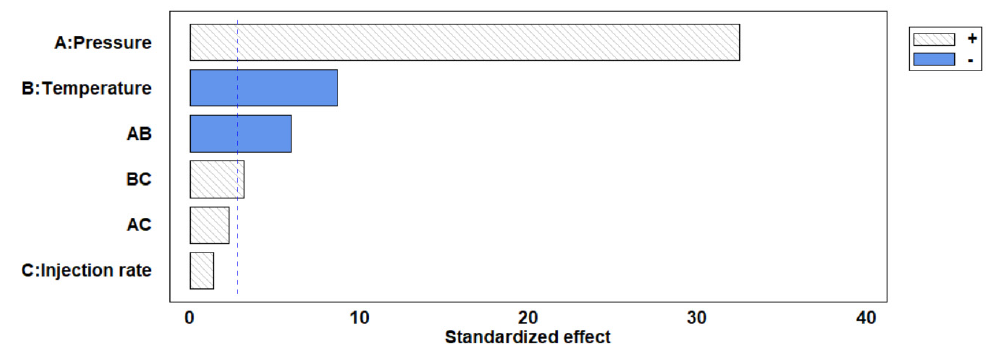
Figure 5. Pareto diagram representing the effect of different parameters on the TPC. “+” (positive effect) “ − ” (negative effect).